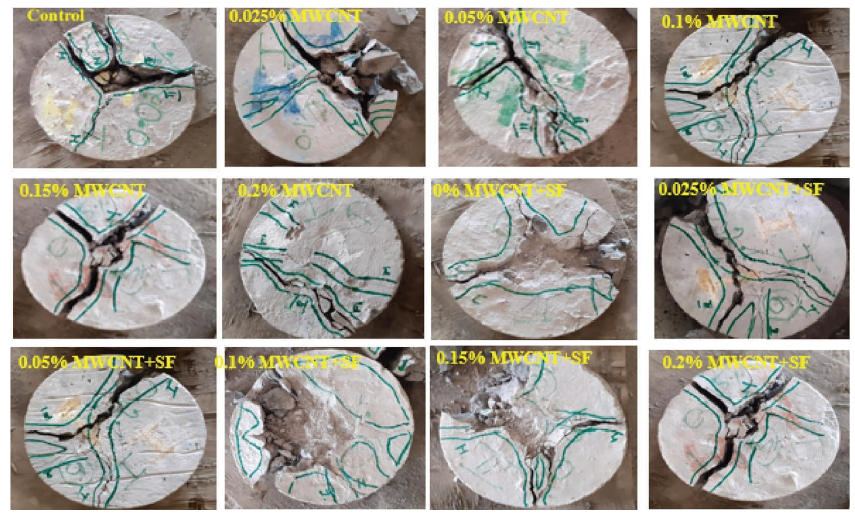
Figure 14: Crack pattern of the failed